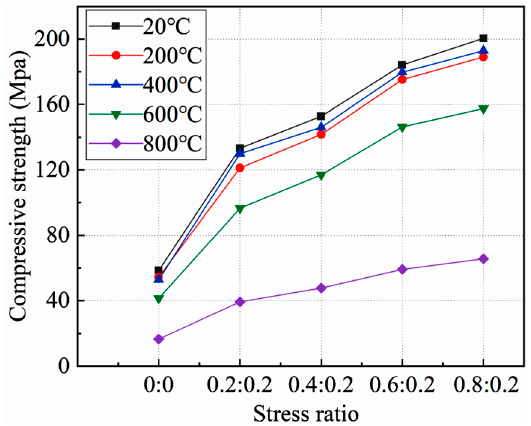
Figure 5. Relationship between static compressive strength and side pressure ratio of concrete.